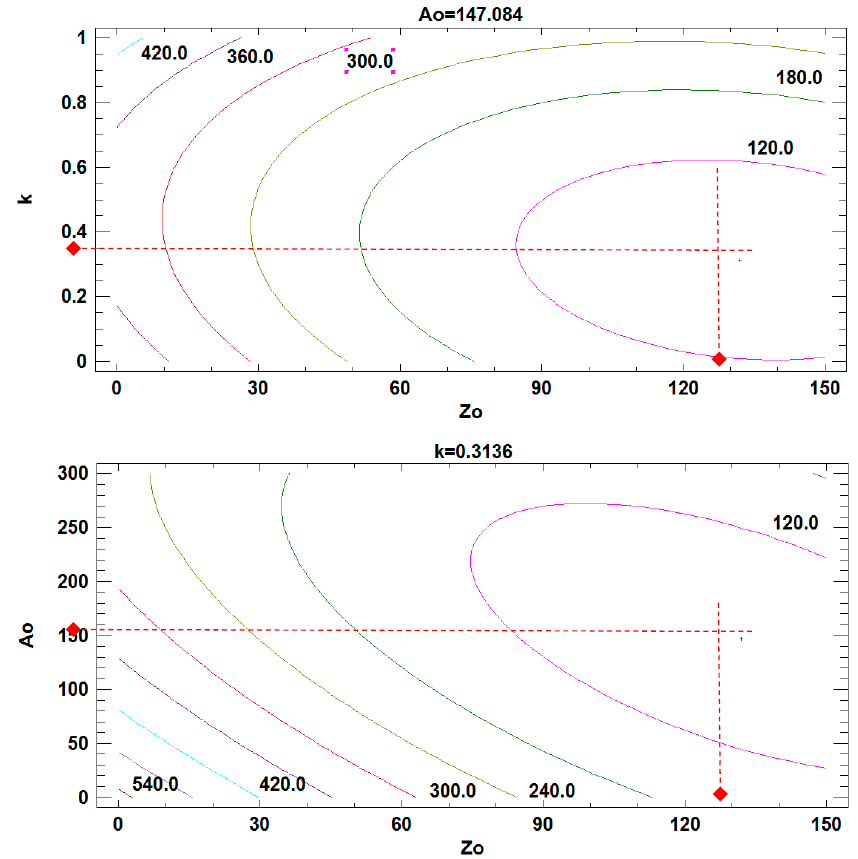
Figure 3. Cost projection of the estimated expected total cost.